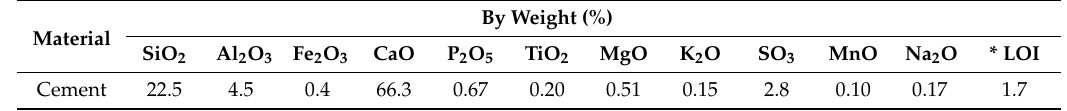
Table 1. Chemical composition of Portland cement (PC).